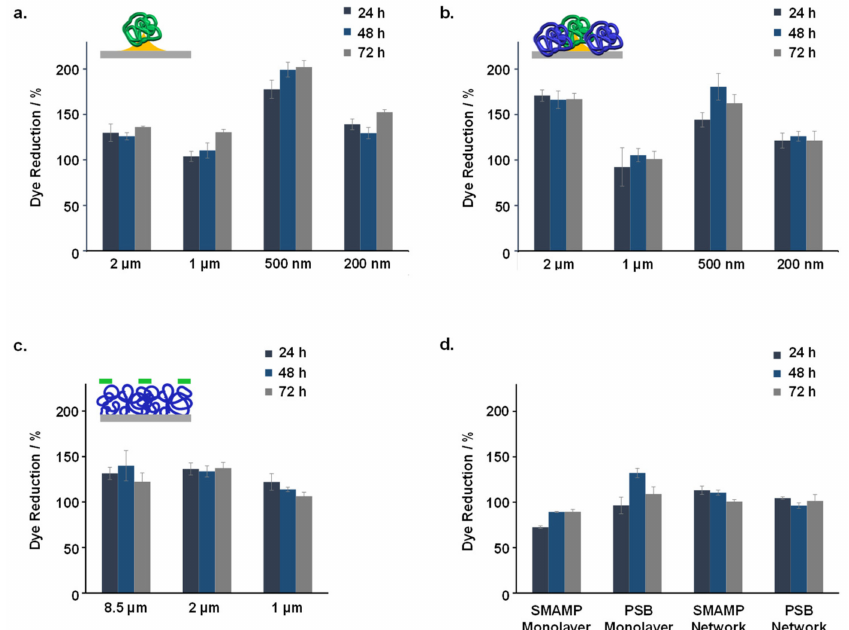
Figure 6. Normalized relative dye reduction (in %) due to keratinocytes grown on the structured and functionalized samples: ( a ). SMAMP@Au_Si with 200 nm to 2 µ m spacing; ( b ). SMAMP@Au_PSB@Si with 200 nm to 2 µ m spacing; ( c ). SMAMP@PSB samples with 1 µ m to 8.5 µ m spacing; ( d ). SMAMP monolayer and PSB monolayer , and SMAMP network and PSB network . The data for each sample was recorded after 24, 48, and 72 h of incubation time, respectively. The error bars are the standard deviation calculated from two independent experiments using three replicates